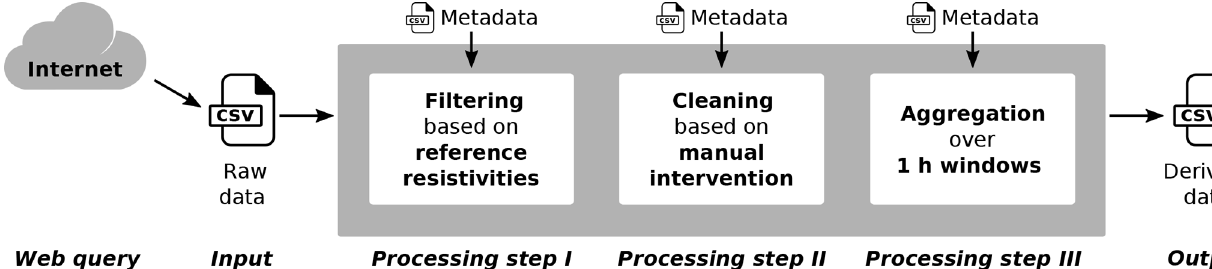
Figure 11. Three-step data processing methodology for PermaSense sensor data.